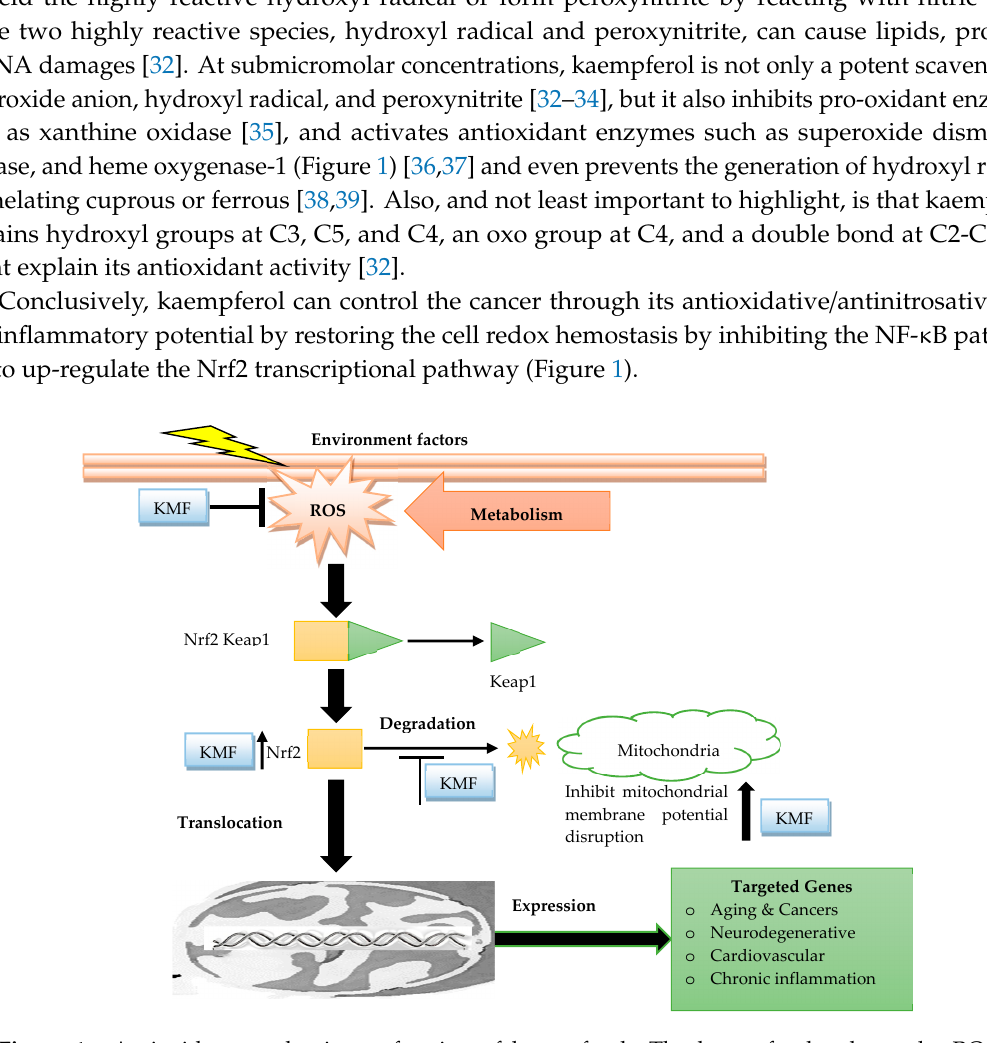
Figure 1. Antioxidant mechanisms of action of kaempferol: The kaempferol reduces the ROS metabolism, cleavage of anti-inflammatory membranes, and disrupts their molecular mechanism as a mechanistic concern to tackle cancer-related expressions (KMF: Kaempferol; Nrf2: Nuclear factor erythroid 2-related factor 2; Keap1: Kelch-like ECH-associated protein 1; RO: Reactive oxygen